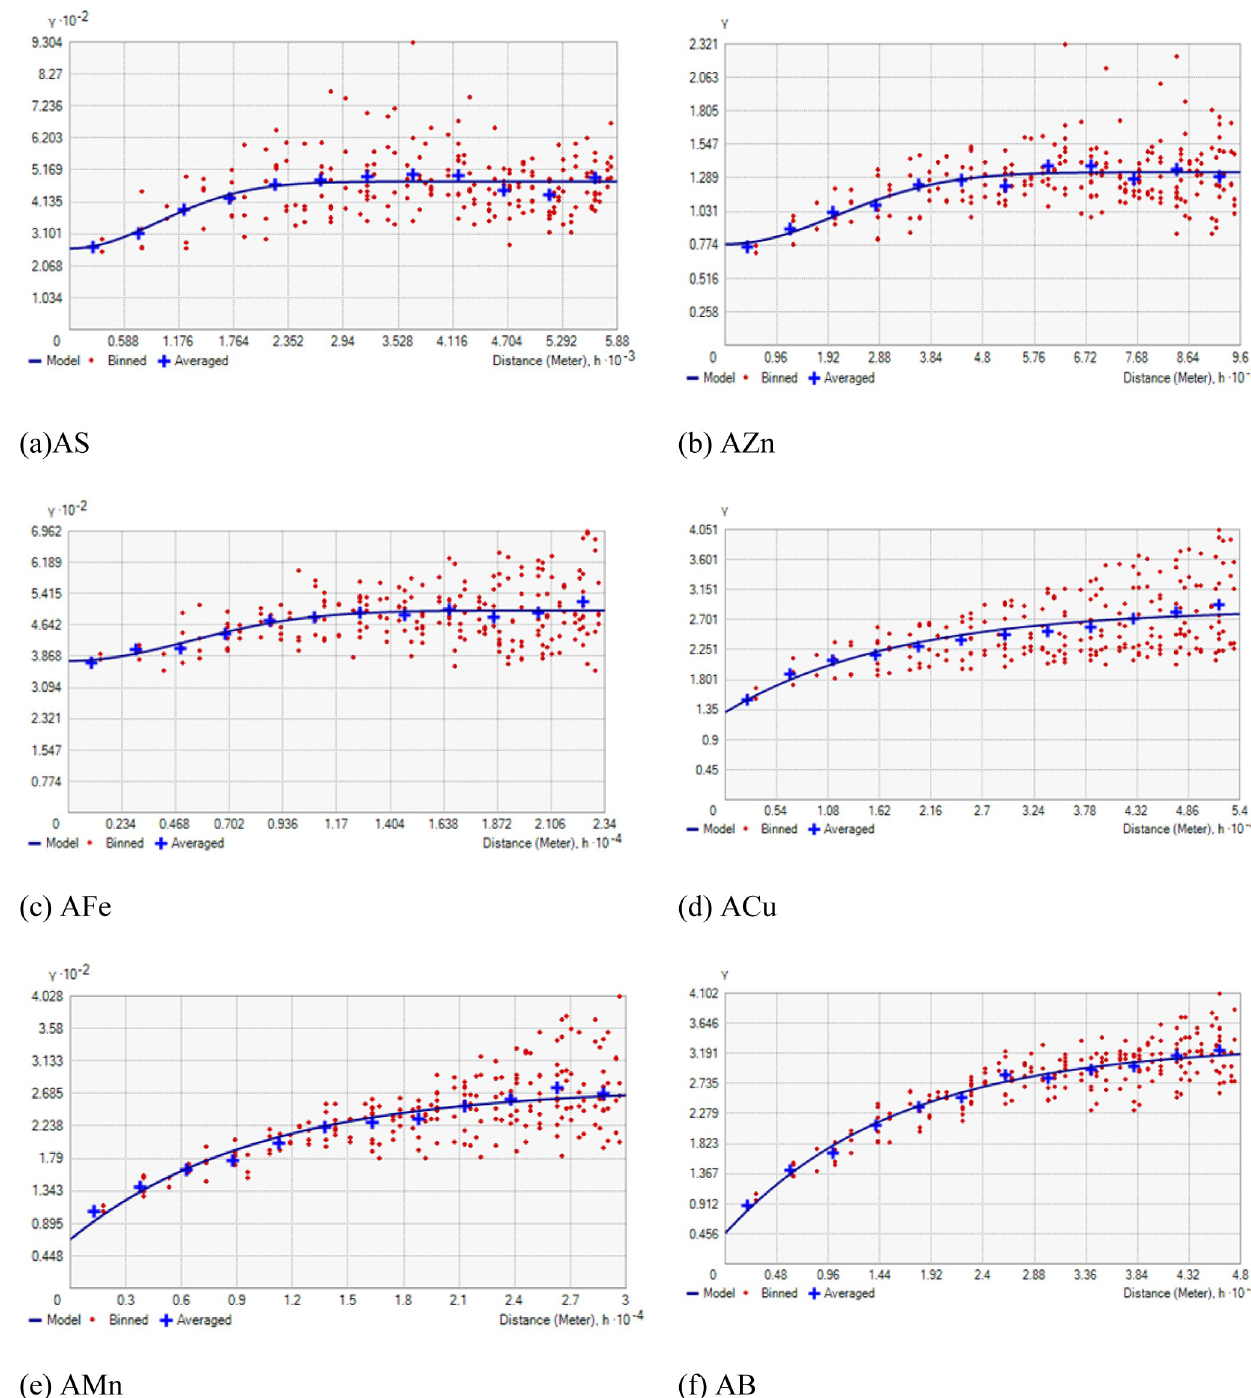
Fig 2. Semivariograms of available nutrients in study area. AS = available sulphur, AZn = available zinc, AFe = available iron, ACu = available copper, AMn = available manganese, AB = available B.